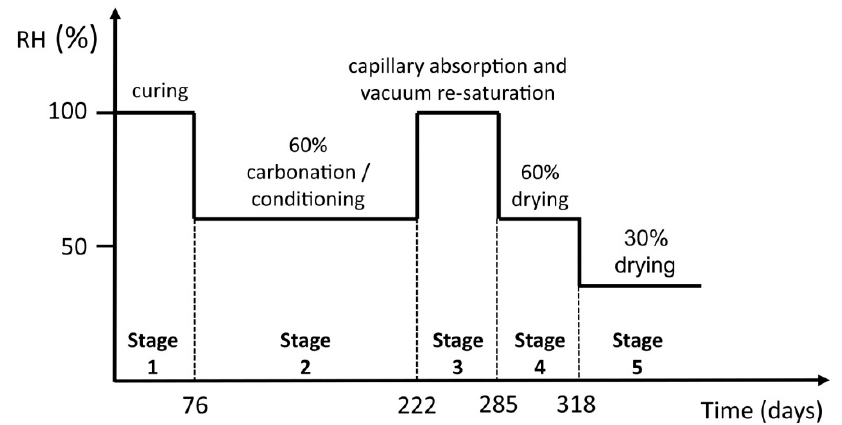
Figure 3. Stages of the moisture transport experiment carried out on the thin plates.